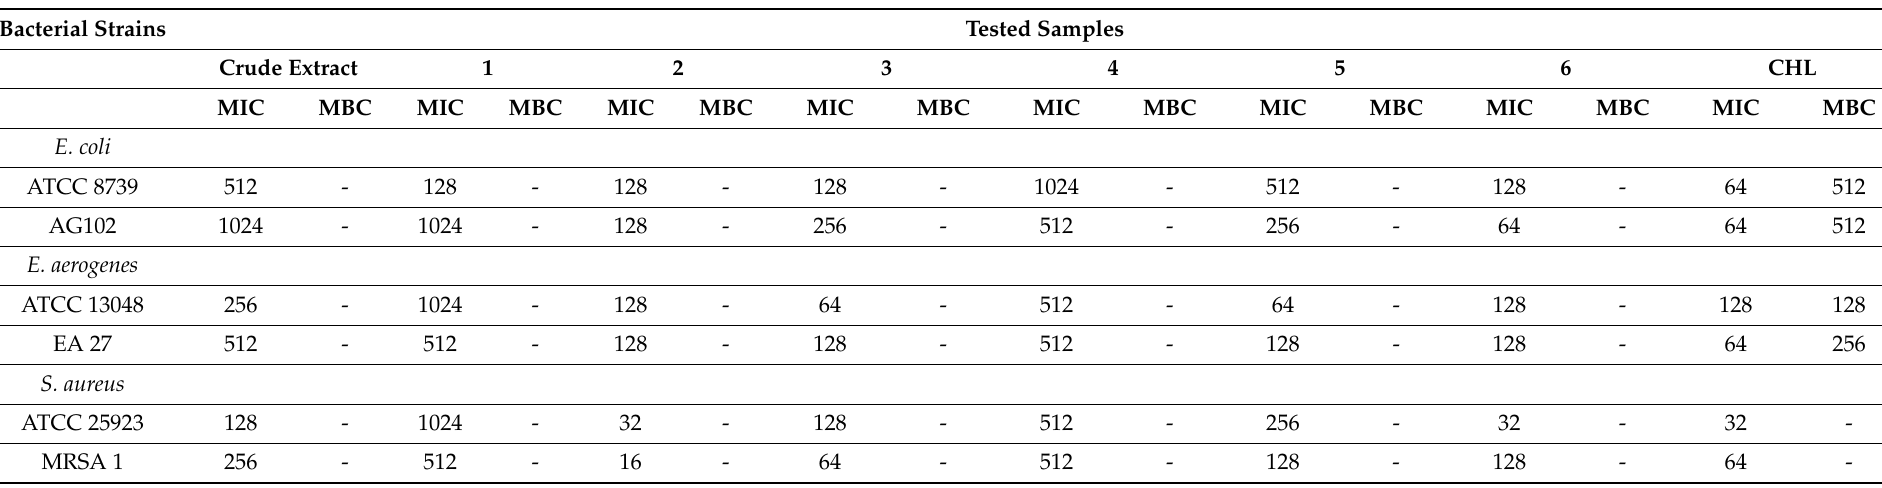
Table 3. MIC and MBC values ( µ g/mL) of crude extract and isolated